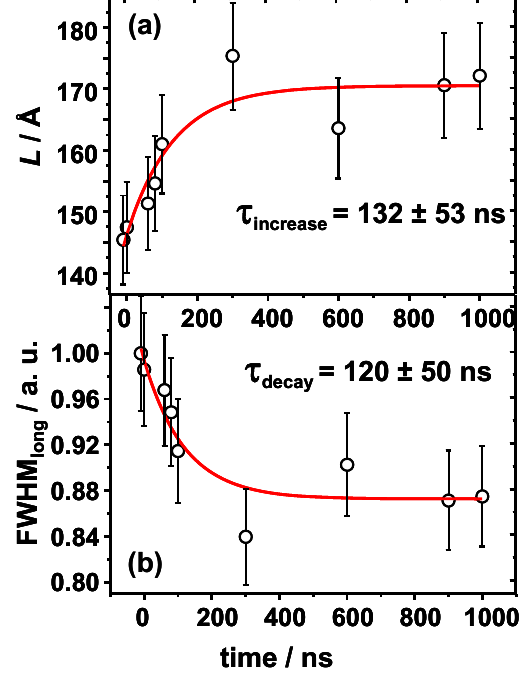
Figure 10. (a) Time-resolved evolution of the crystallite thickness. The thickness of the crystallite does increase for 20% of its original value. (b) Time evolution of the FWHM along the longitudinal